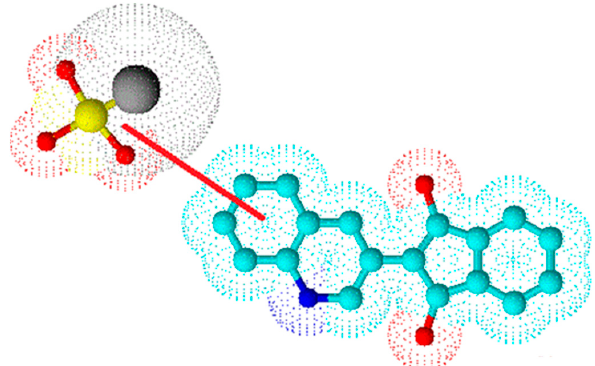
Figure 14. Quinoline Yellow structure using ChemSketch software.